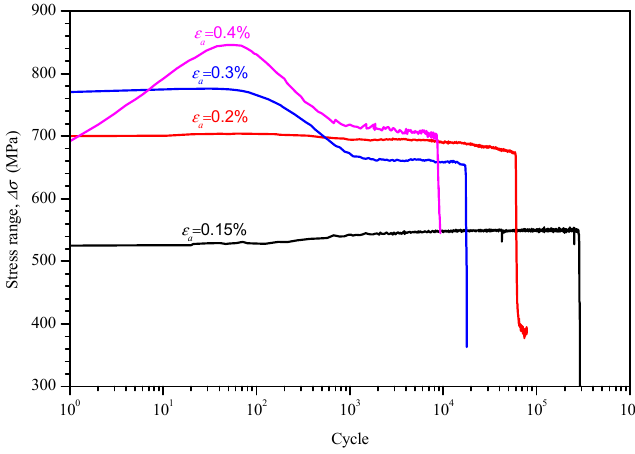
Figure 8. Cyclic stress range with number of cycles.